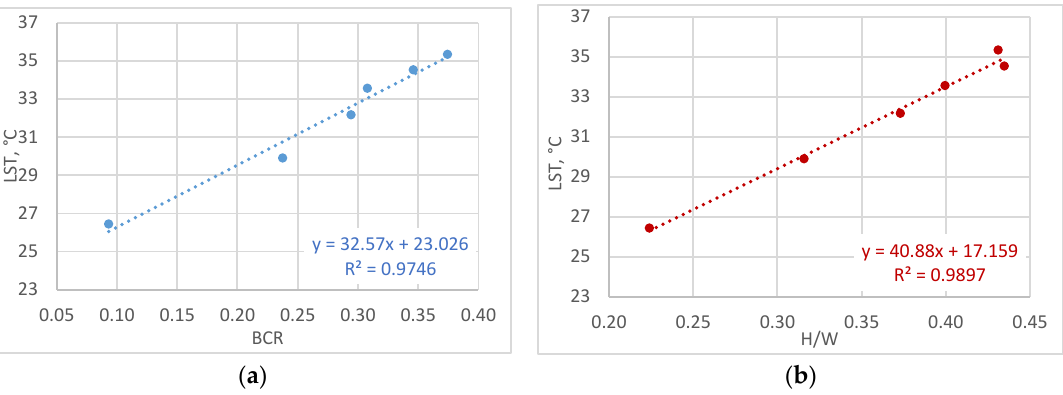
Figure 20. Aggregated data: correlations between LST and ( a ) BCR; ( b ) H/W.